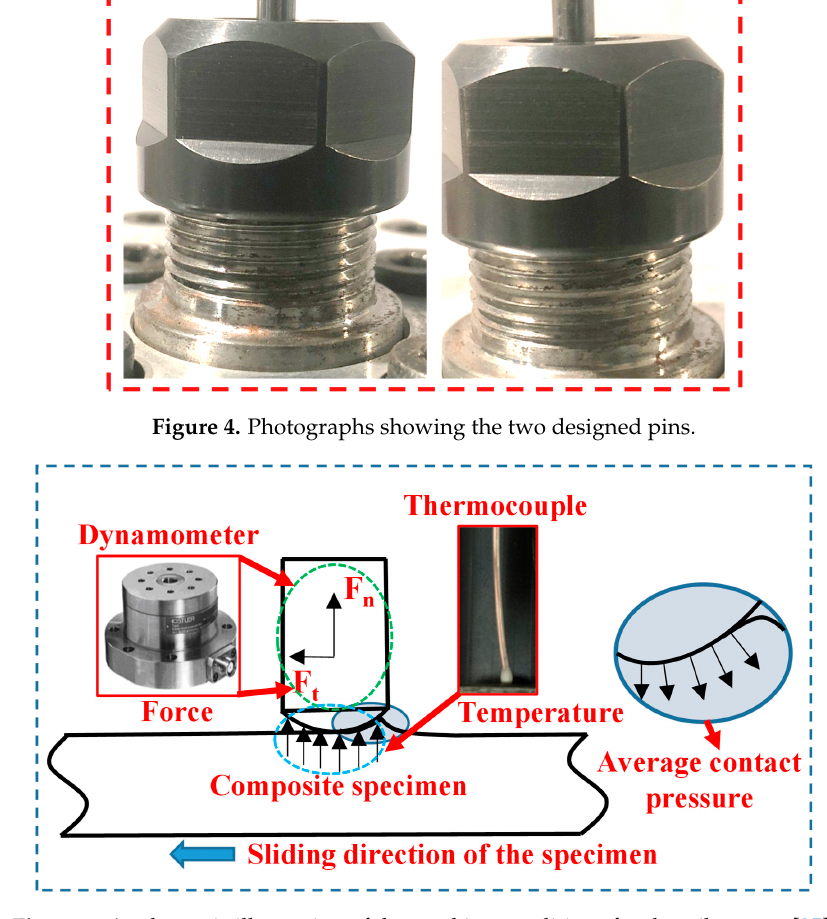
Figure 5. A schematic illustration of the working conditions for the tribometer